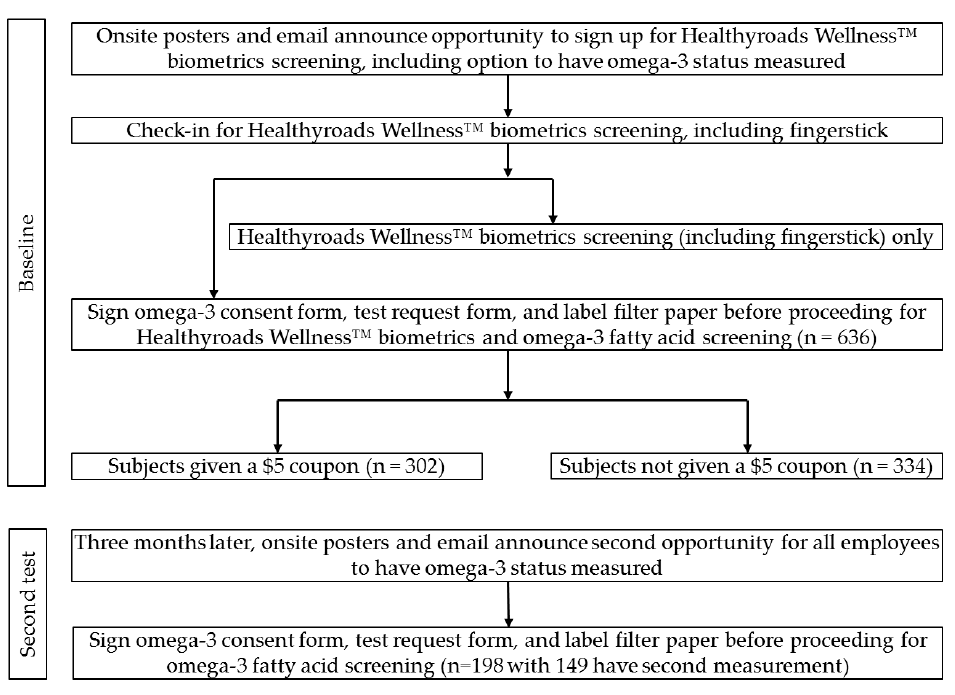
Figure 1. The flow diagram describing enrollment and participation in omega-3 screening.